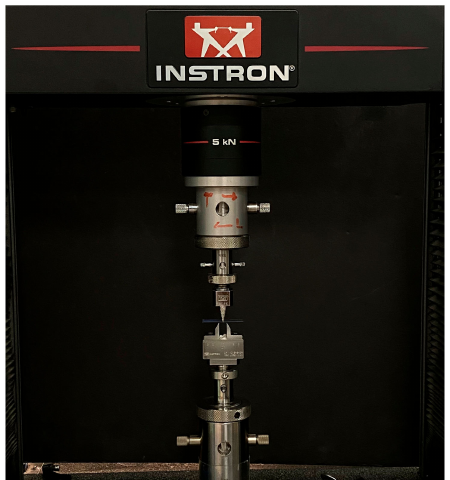
Figure 4. Three-point testing using Instron 5965 system (Instron, Canton, MA,